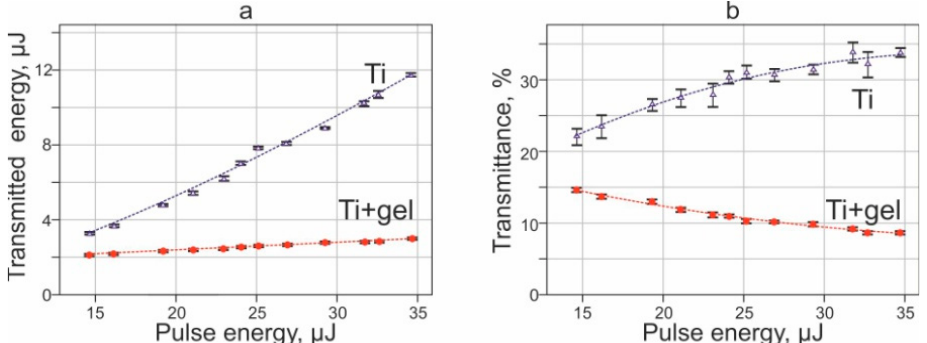
Figure 5. Dependences of the transmitted laser energy ( a ) and transmittance of donor slide ( b ) in the cases of a pure Ti film without gel layer (Ti) and a gel layer on a Ti film (Ti + gel).